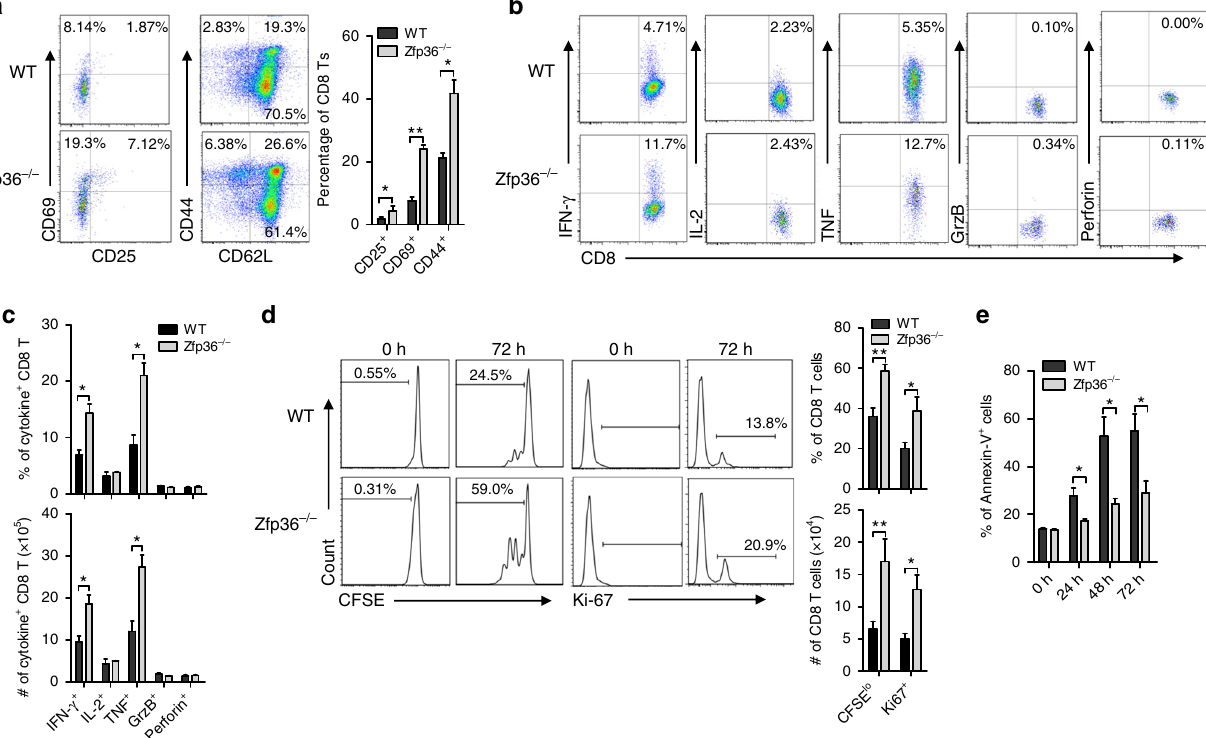
Fig. 1 TTP de fi ciency promotes CD8+ T-cell activation. a Single splenocytes from female Zfp36 − / − mice and WT littermates at 6 weeks old were stained with antibodies against CD3, CD8, CD44, CD25, CD69 and CD62L. Surface expression levels were detected with fl ow cytometry by gating on CD3CD8 double positive cells. Quantitative data represent means ± s.d. from three independent experiments. b The above splenocytes were stimulated by PMA and Ionomycin in the presence of Golgistop for 4 h, then intracellular IFN- γ , IL-2, TNF, Granzyme B and Perforin positive cells were detected with their respective antibodies, gated on CD3CD8 double positive cells. c Quantitative data represent means ± s.d. of cytokine + CD8 + T-cells from four pair of mice as in b . d Naive CD8 T-cells isolated from spleens of WT and Zfp36 − / − mice were labeled by CFSE and stimulated by plate-coated α -CD3/CD28 Abs (1 μ g/ml) for 72 h. Then CFSE and Ki67 levels were detected by FACS. Quantitative data represent means ± s.d. from three independent experiments. e Naive CD8 T-cells isolated from spleens of WT and Zfp36 − / − mice were stimulated by plate-coated α -CD3/CD28 Abs (1 μ g/ml) for different times. The percentages of Annexin-V + apoptotic CD8 T-cells were detected by FACS and summarized as means ± s.d. from three independent experiments. Unpaired student ’ s t test was used for comparison as in ( a – e ), with ** p < 0.01; * p < 0.05 vs. WT